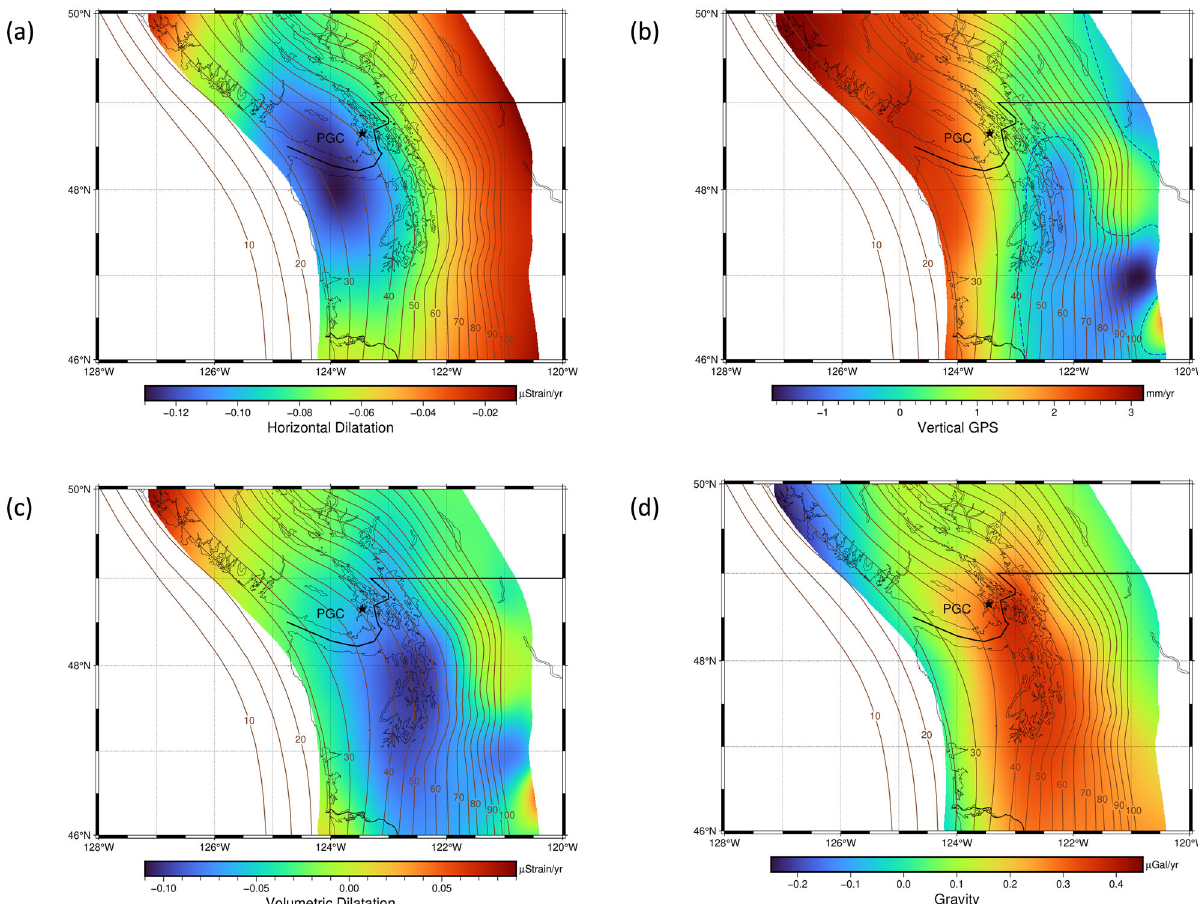
Fig. 5 Gravity effect of dilatation. a Horizontal dilatation strain, ( b ) vertical GPS velocity (Blue dashed curve represents zero vertical velocity), and ( c ) volumetric dilatation strain derived from GPS velocities in the Paci fi c Northwest region; ( d ) Gravity effect of volumetric dilatation strain. Contours show Cascadia plate interface geometry based on the slab contours of McCrory et al. 72 . The maps were created by using the Generic Mapping Tools (GMT) 71